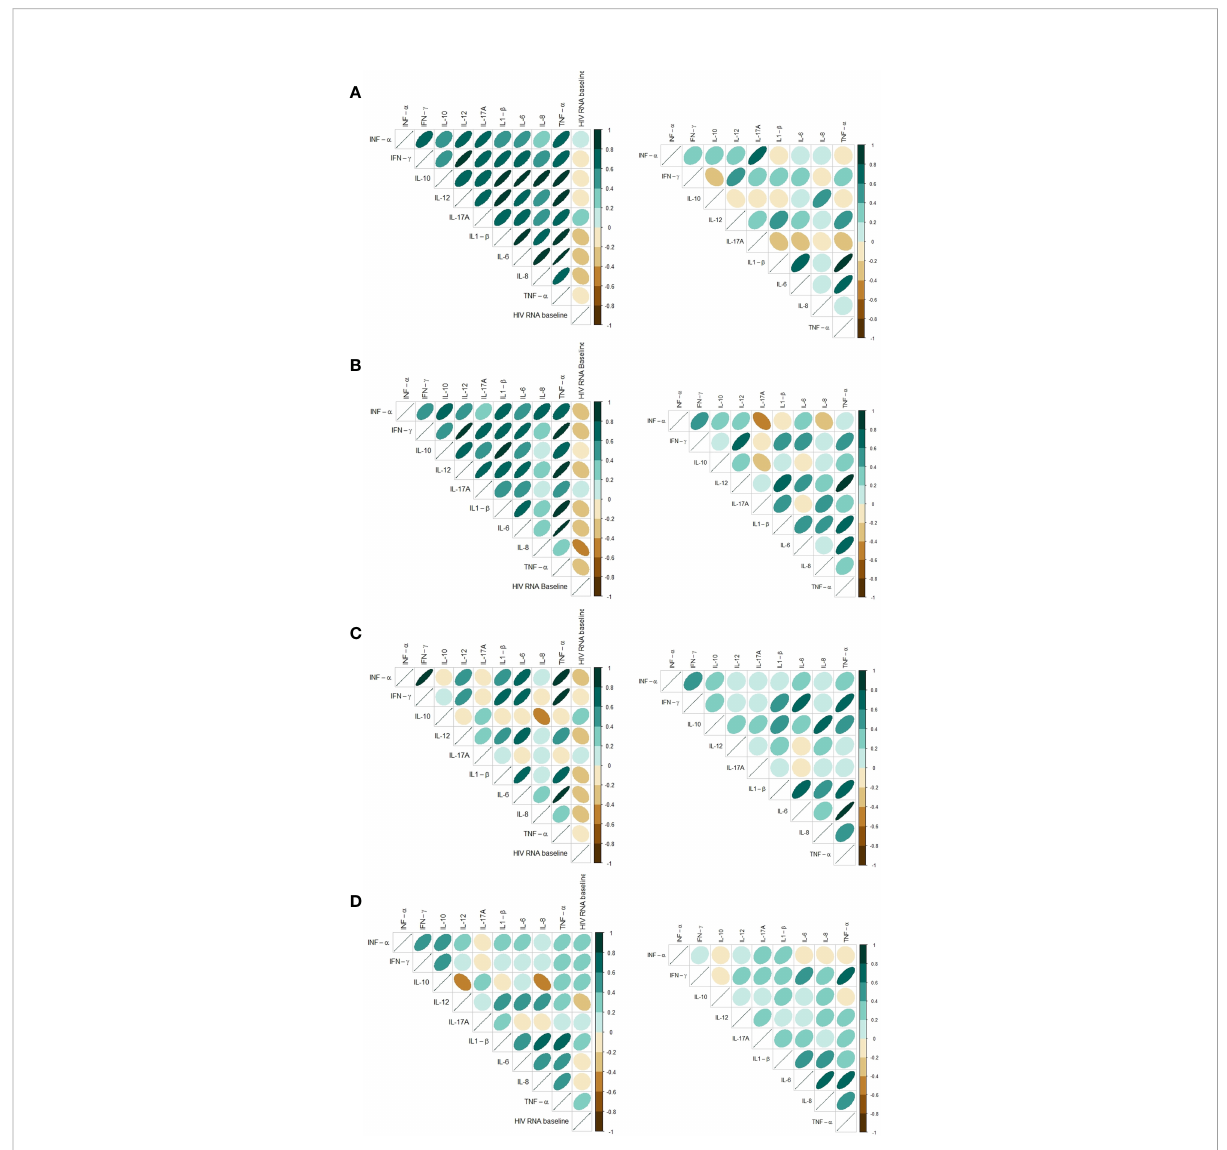
FIGURE 3 Correlation matrix based on Spearman ’ s rank correlation coef fi cients for baseline and 12 months follow-up showing cytokine intercorrelation and correlation to HIV RNA at baseline. Only includes participants with samples at both timepoints. (A) Stimuli: LPS, (B) Stimuli: R848, (C) Stimuli: Poly I:C, (D) Unstimulated